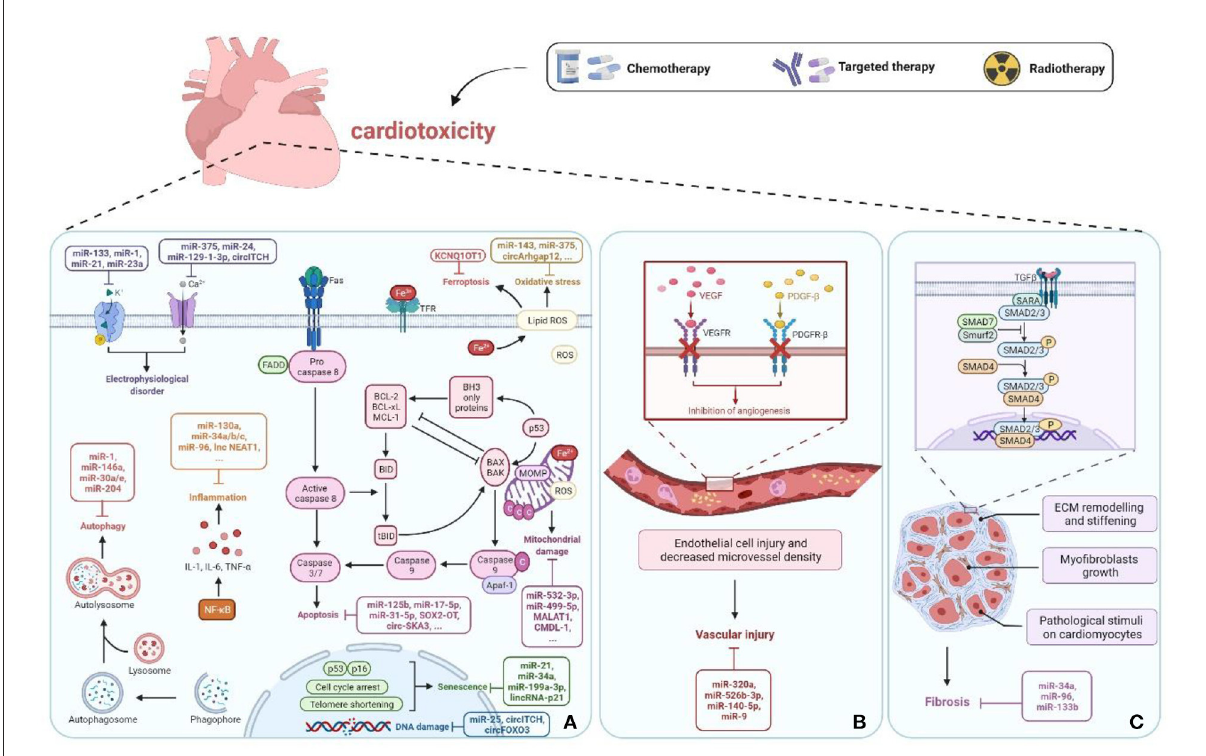
FIGURE2 ncRNAs in cancer therapy-induced cardiotoxicity. (A) ncRNAs cause cell damage or death through regulation of apoptosis, mitochondrial damage, oxidative stress, DNA damage, inflammation, autophagy, senescence, electrophysiological disorders, and ferroptosis pathways. (B) Vascular homeostasis disorder. (C) Fibrosis. Created with